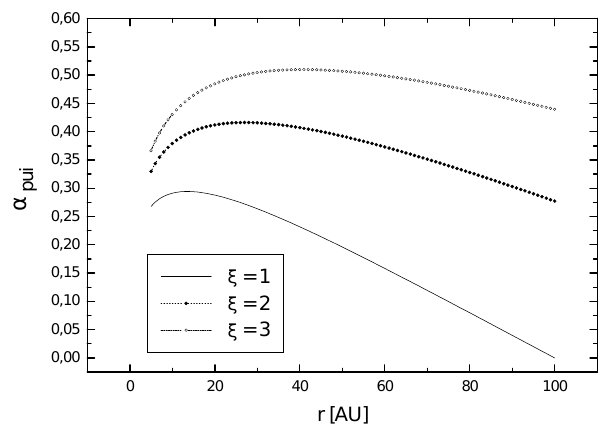
Fig. 1. Shown is the function α pui as function of the solar distance in the upwind direction for differerent values 0 = L m /λ k = 20 ( ξ = 1), 30 ( ξ = 2), 40 ( ξ =